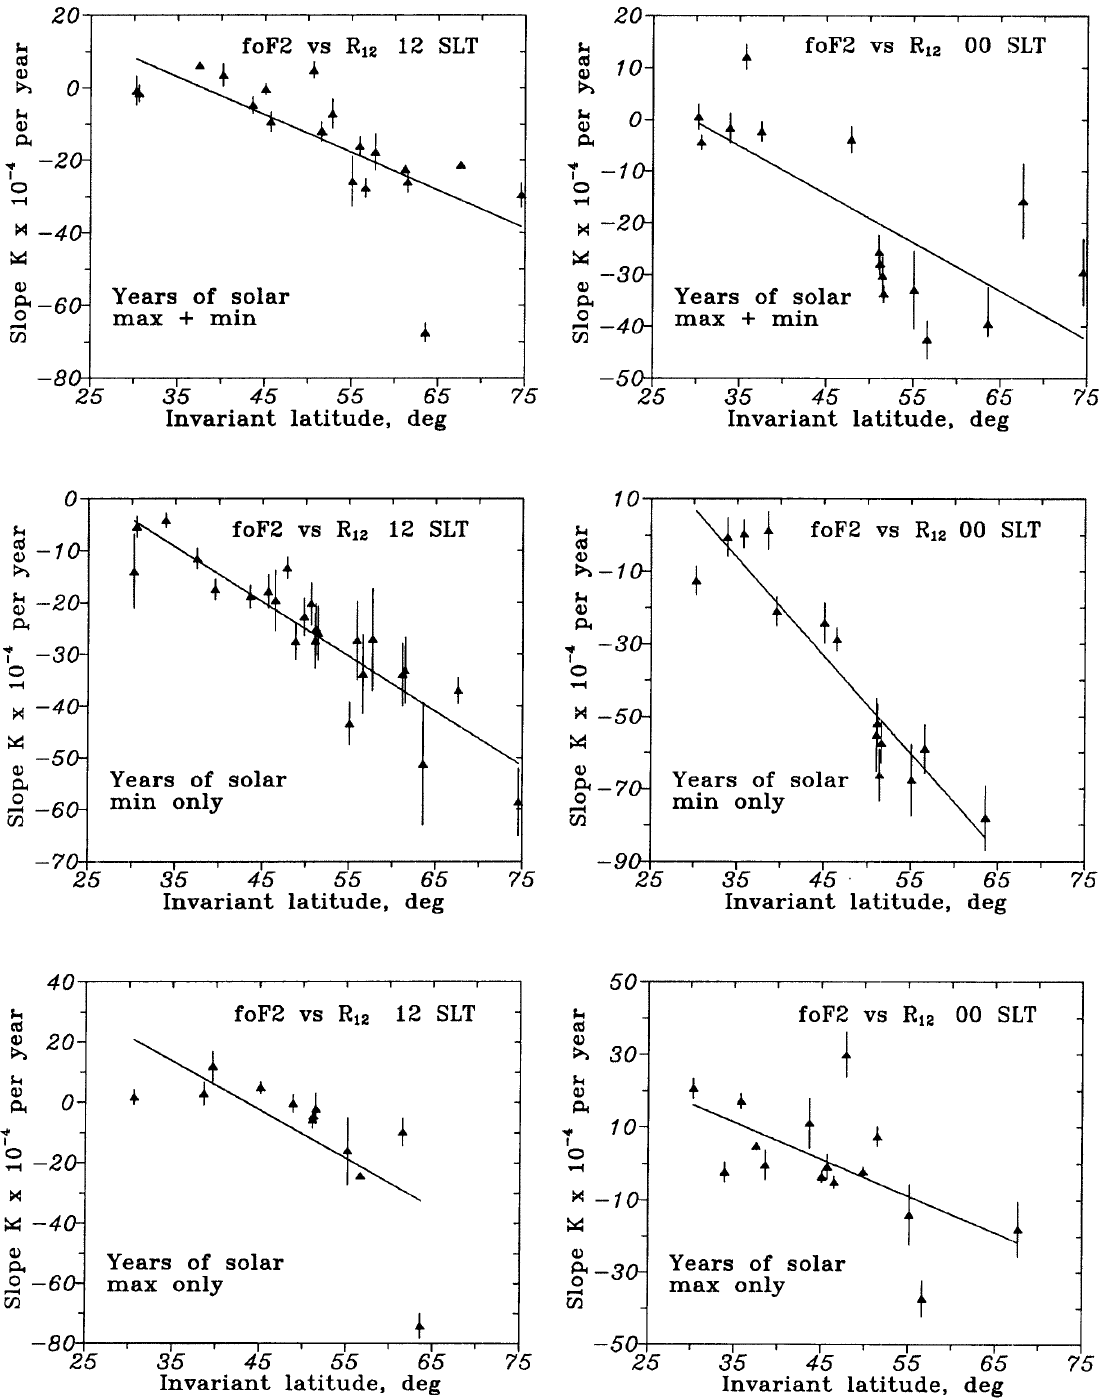
Fig. 2. Daytime and nighttime annual mean slope K at stations versus Only stations with significant trends and a confidence level ‡ 90% are invariant latitude for the period with increasing geomagnetic activity shown. Error bars present the standard deviation of seasonal (over 12 1965–1991. Model 1 ( f oF2 versus R regression) and three year months) scatter of the slope 12 selections: ( M + m ), ( m ) and ( M ) are used in the analysis (see text).